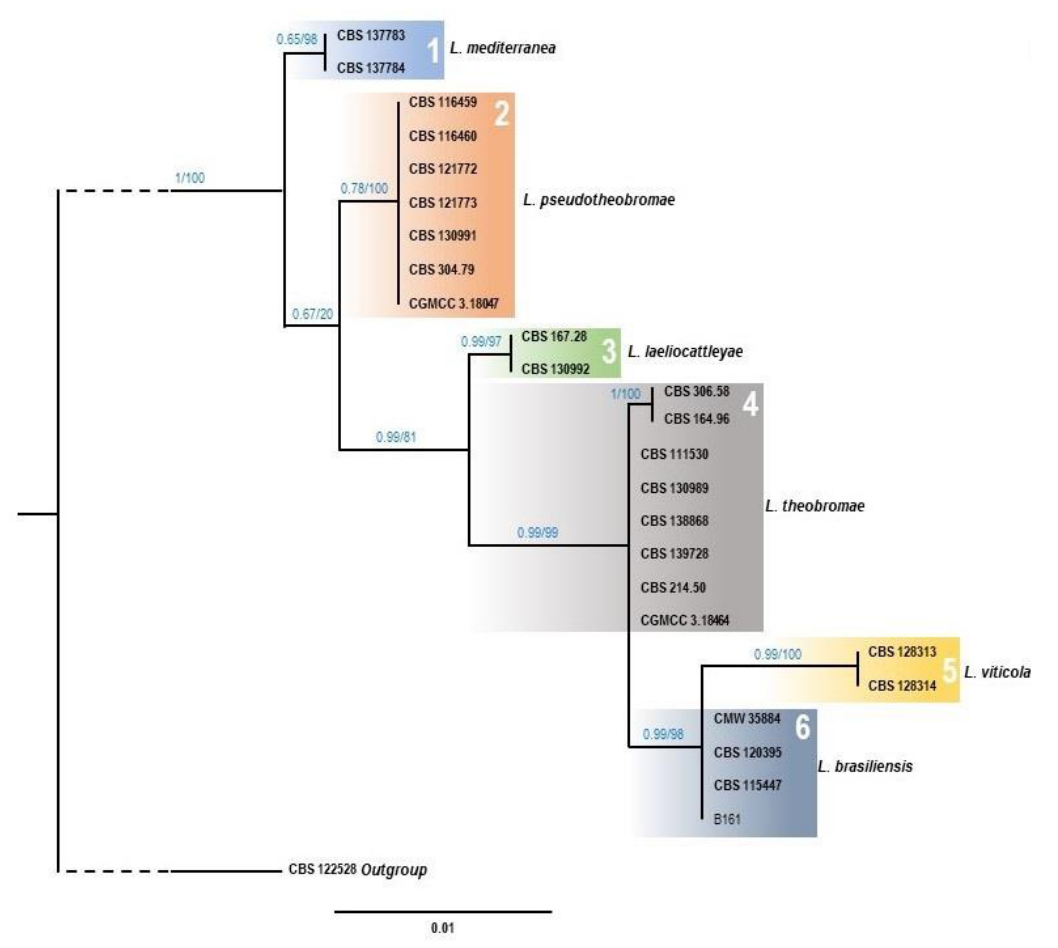
Figure 3. Phylogenetic tree of Lasiodiplodia species resulting from a Bayesian analysis of the combined ITS1-2, tef1 and tub2 sequence alignment. Maximum likelihood bootstrap values and Bayesian posterior probabilities are shown at the nodes. Ex-type strains are indicated in bold font. The tree was rooted to Neodeightonia phoenicum (CBS 122528).